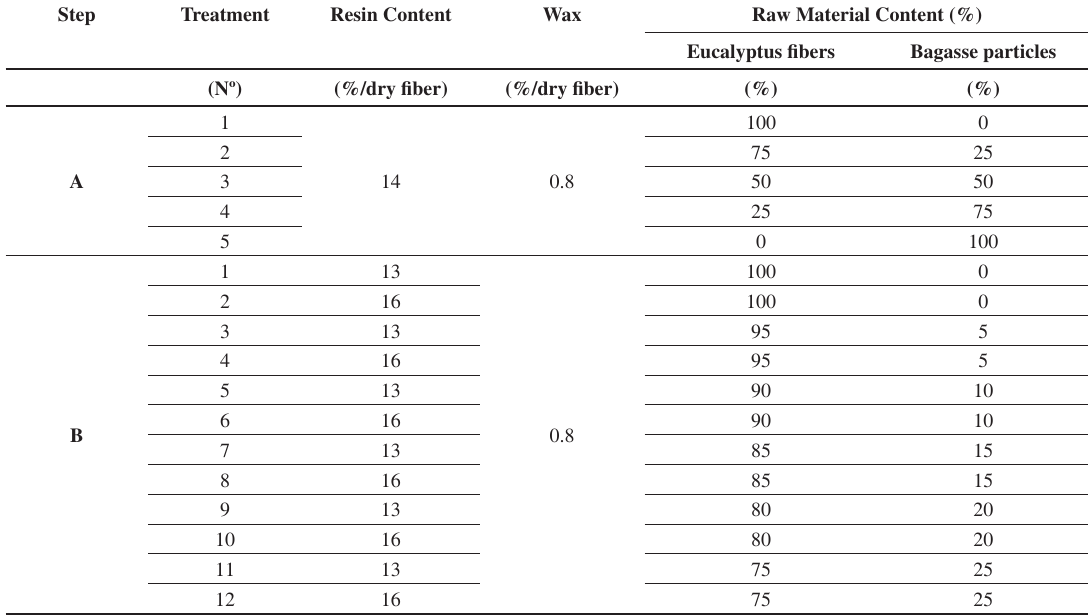
Table 1. Treatments proposed for panel manufacture in steps A and B. Step